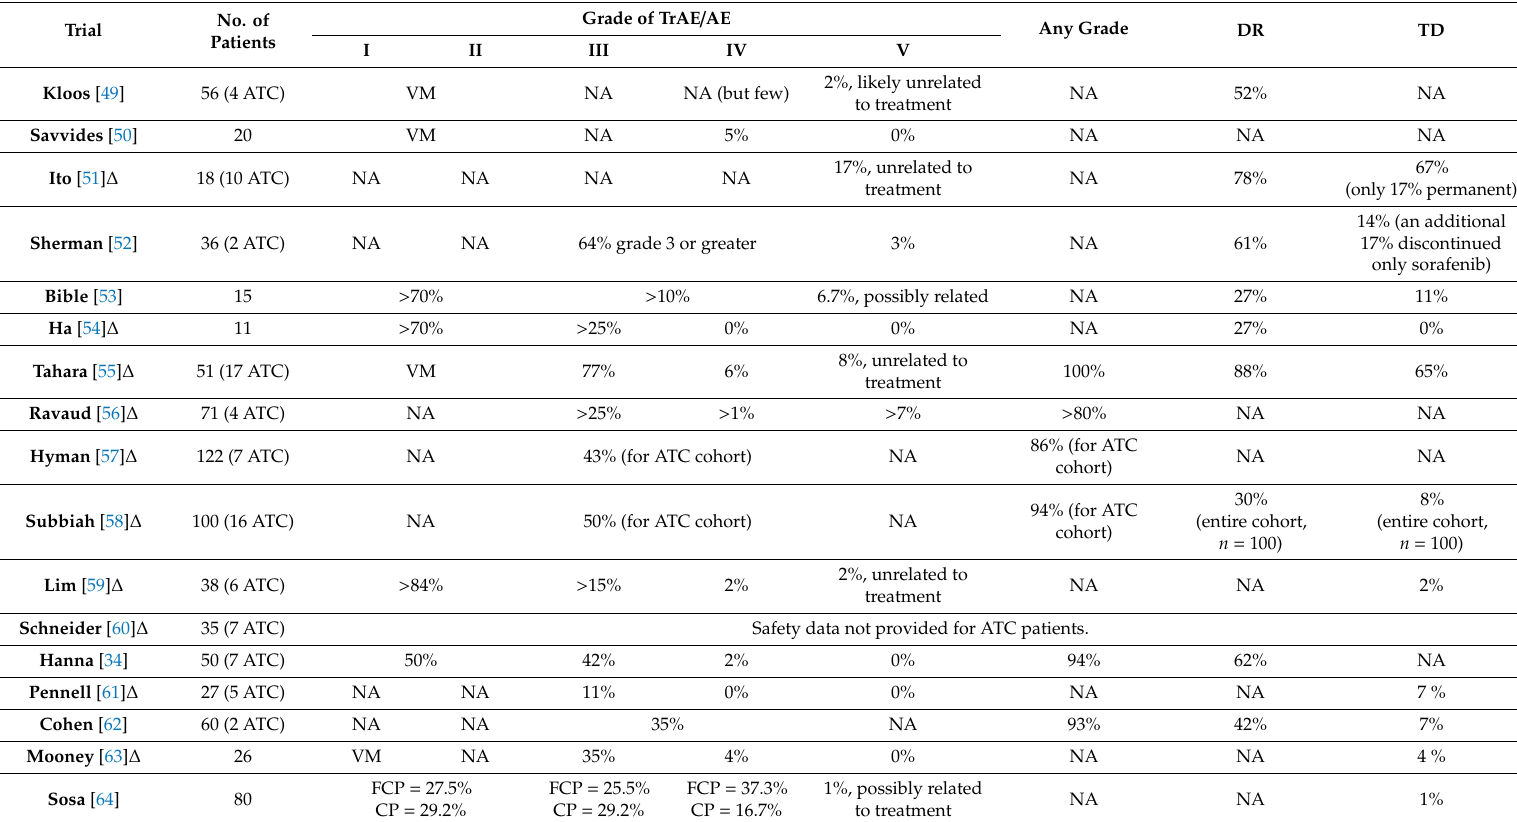
Table 3. Overview of adverse events (AEs) and treatment-related adverse events (TrAE) in phase II trials testing targeted therapy in ATC patients. No. of Trial